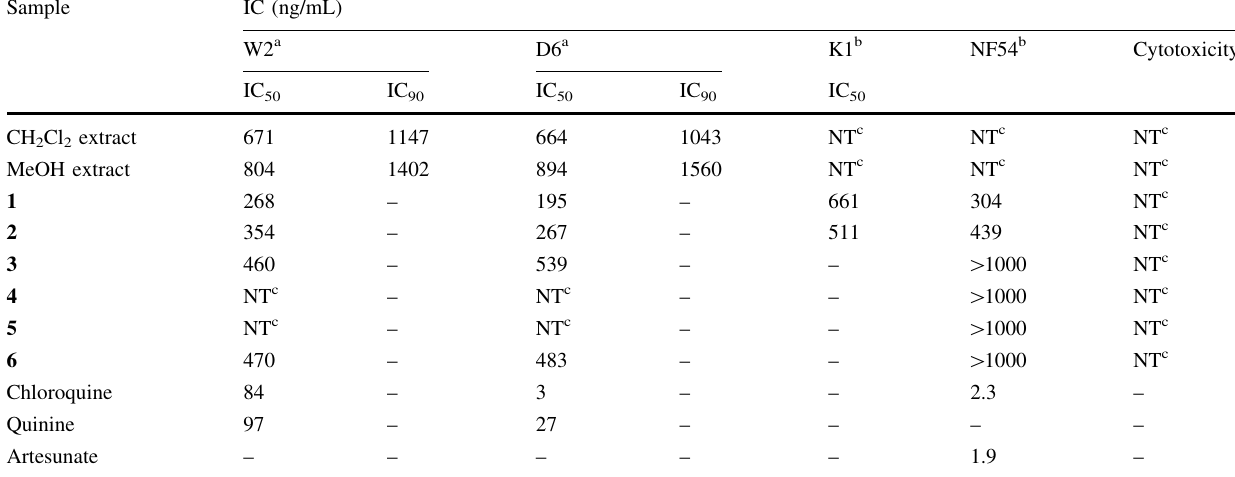
Table 3 Antimalarial activity of crude S. striatinux extracts and compounds 1 – 6 Sample